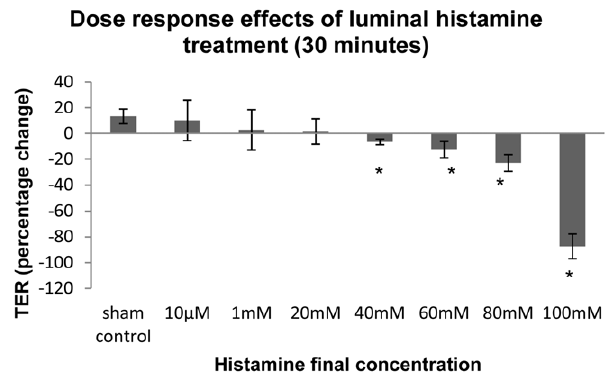
Figure 3. Dose-response effects for 30 minutes luminal hista- mine treatment. Histamine (40 mM to 100 mM) significantly (p , 0.05) decreases TER in native ovine vocal fold epithelium in a dose- dependent manner. Data represent the mean and standard deviation of percentage change (%) in TER.